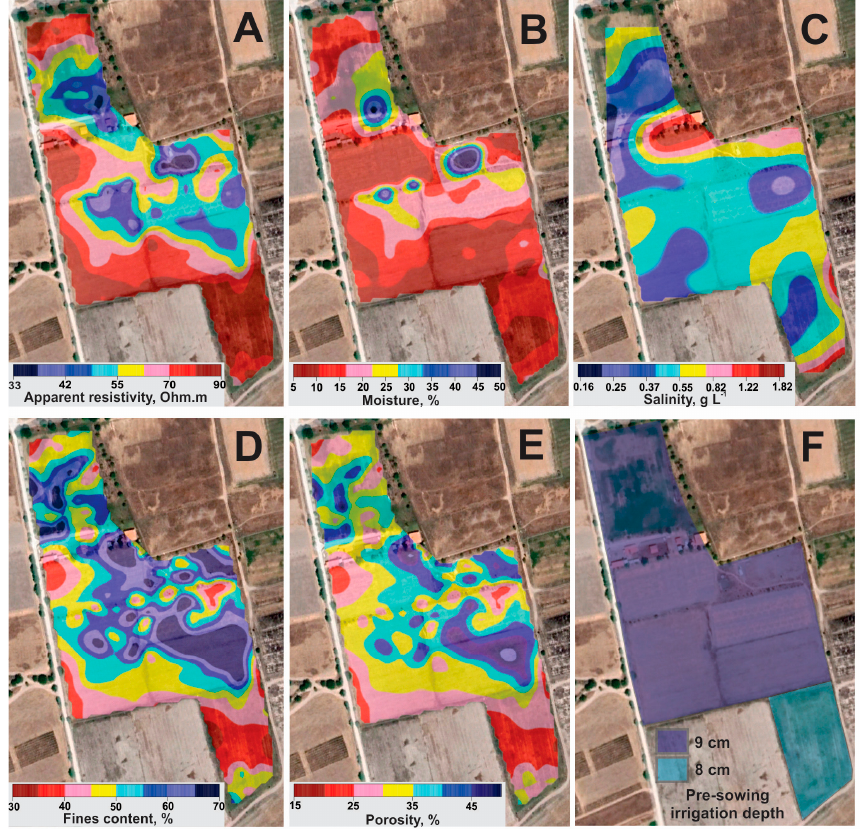
Figure 5. ( A ) soil apparent resistivity, ( B ) moisture, ( C ) salinity ( D ) fines content, ( E ) porosity and ( F ) PSID maps.